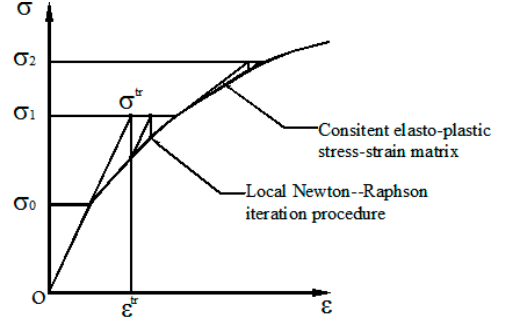
Figure 12. Sketch of the Newton-Raphson (N-R) iteration.